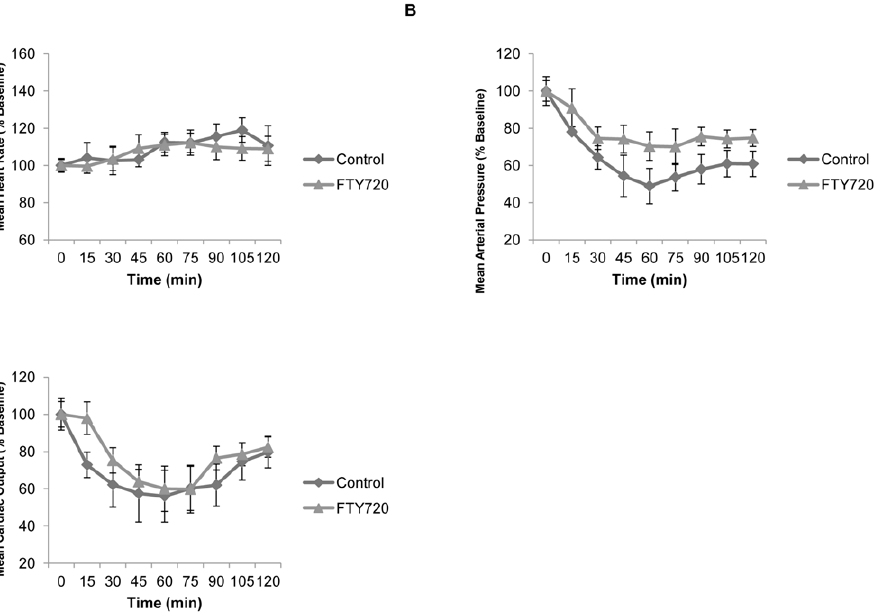
Figure 2. Hemodynamic profiles during hemorrhage period for FTY720 and vehicle control (in this and subsequent figures control is used for vehicle control) groups. a ) Heart rate. b ) Mean arterial pressure. c ) Cardiac output. There were no statistical differences between the control and experimental hemodynamic profiles.